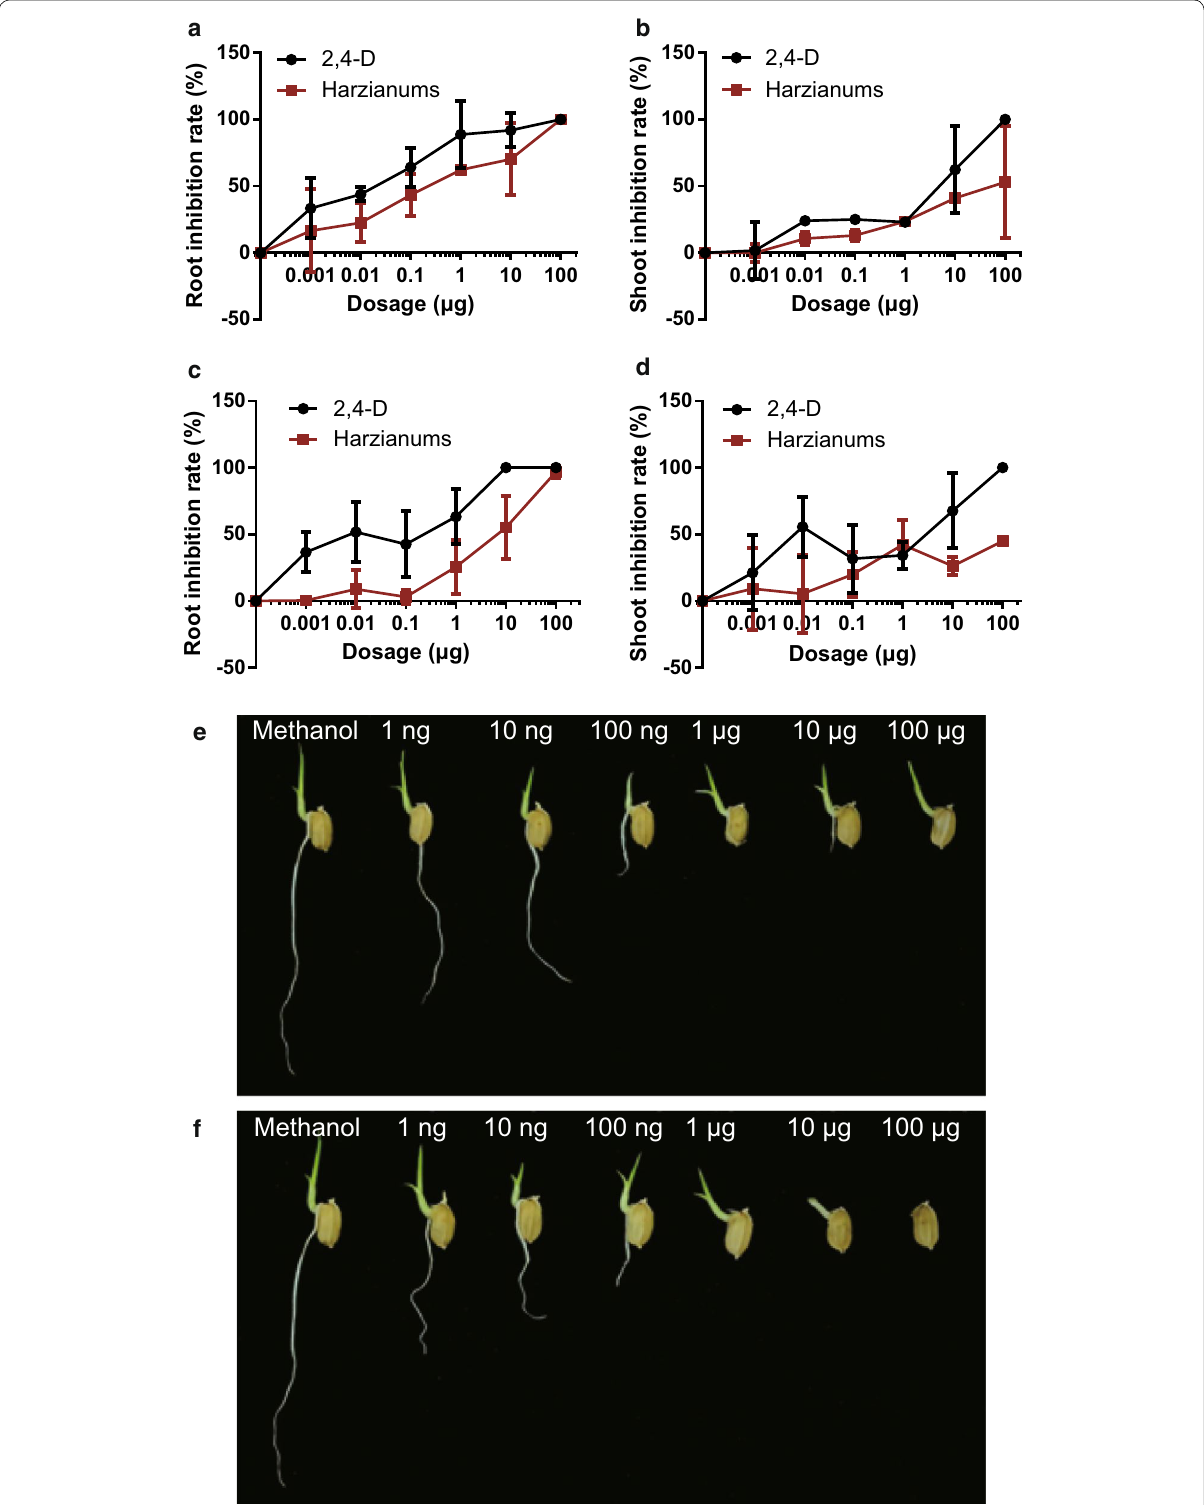
Fig. 3 The phytotoxic effect of HA and HB ( 1 – 2 ) on rice or E. crusgalli L. Beauv. compared to the positive control, 2,4-D. The inhibition rate of a , c root or b , d shoot length by HA and HB or 2,4-D to a , b rice or c , d E. crusgalli L. Beauv., respectively (n after treatment with e HA and HB or f